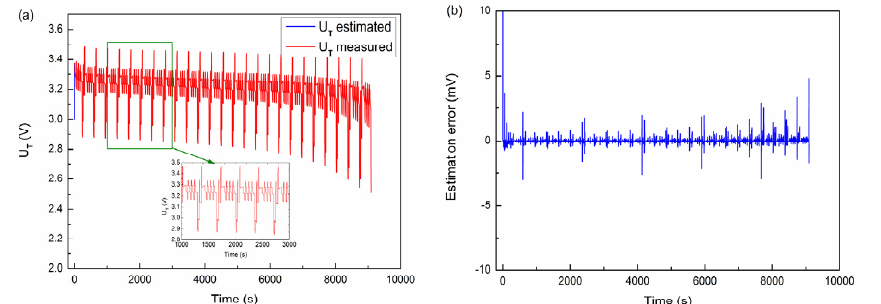
Figure 13. Validation of the identification method in the DST test at 0 °C: ( a ) the estimated voltage and measured voltage profiles and ( b ) the estimation